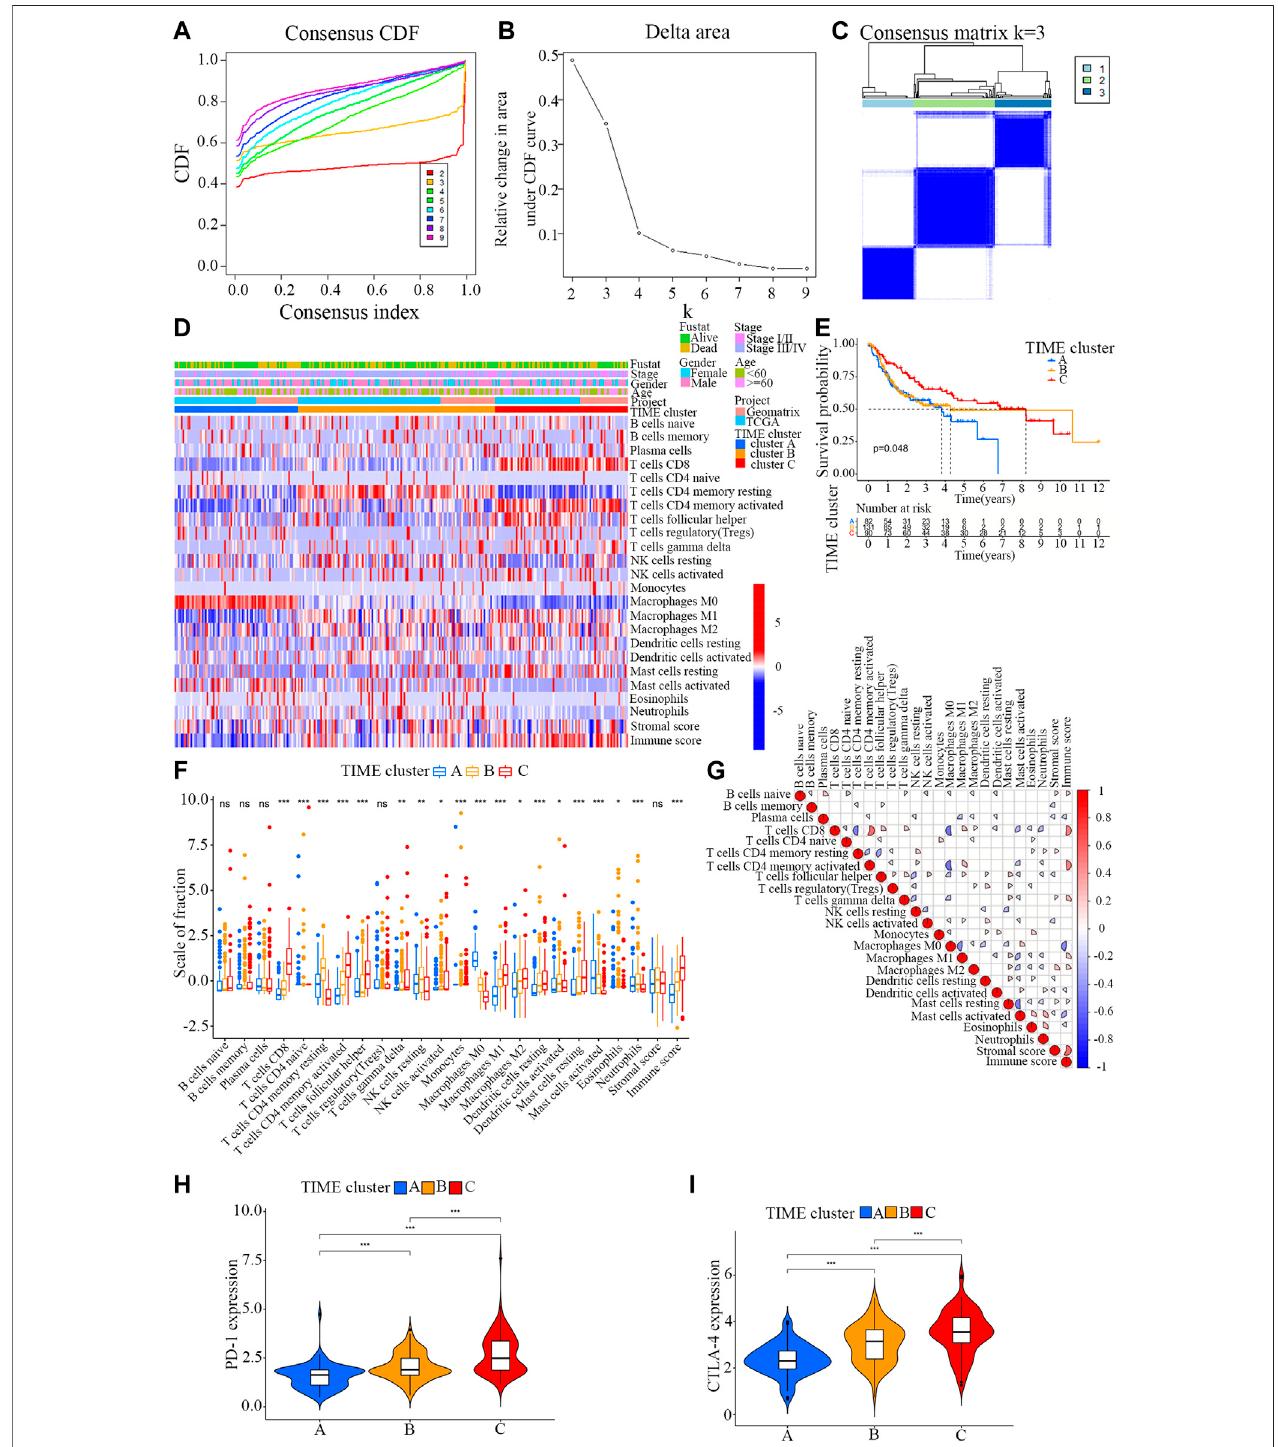
FIGURE 1 | Landscape of the TIME-in fi ltrating cells of OSCC patients. (A) Cumulative distribution function curve of each consensus matrix from k = 2 to k = 9. (B) Relative changes inthe areaunder CDF curve based on different k values. (C) Consensus clusteringof the304 tissue specimensderived from TCGA and GEOdatasets for k = 3. (D) Unsupervised hierarchical clustering analysis of the TIME-in fi ltrating cells derived from TCGA and GEO datasets. Columns denotes tissue specimens and rows denotes TIME-in fi ltrating cells. (E) Overall survival of OSCC patients in the clusters (A,B and C) . Kaplan-Meier curves of OSCC patients with different TIME- in fi ltrating cell populations. Log-rank test, p = 0.048. (F) Distribution of the tumor-in fi ltrating immune cells in the clusters (A,B and C) . Statistical differences among the three TIME clusters were assessed by Kruskal-Wallis test. * p < 0.05; ** p < 0.01; *** p < 0.001. (G) Cellular interaction of the tumor-in fi ltrating immune cells among the three TIME clusters. (H) Difference in PD-1 expression among the three TIME clusters (Kruskal-Wallis test, p < 0.001). (I) Difference in CTLA-4 expression among the three TIME clusters (Kruskal-Wallis test, p < 0.001).